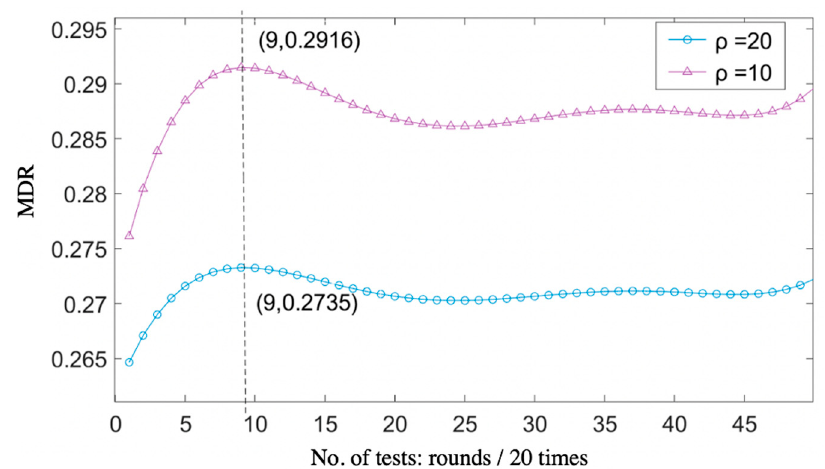
Figure 7. When 𝑘 = −3 , the MDR at 𝜌 = 20 and 𝜌 = 10 is tested separately. The Q table is up- Figure 7. When k = − 3, the MDR at ρ = 20 and ρ = 10 is tested separately. The Q table is updated dated 20 times per round as the number of experimental rounds increases. 20 times per round as the number of experimental rounds